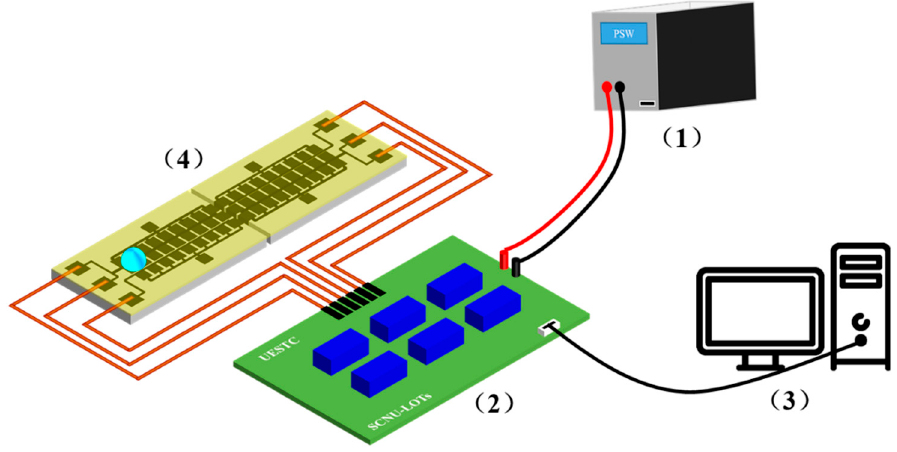
Figure 4. Schematic of the DMF system. ( 1 ) DC source; ( 2 ) a relay; ( 3 ) a computer; ( 4 ) a splicing DMF chip.